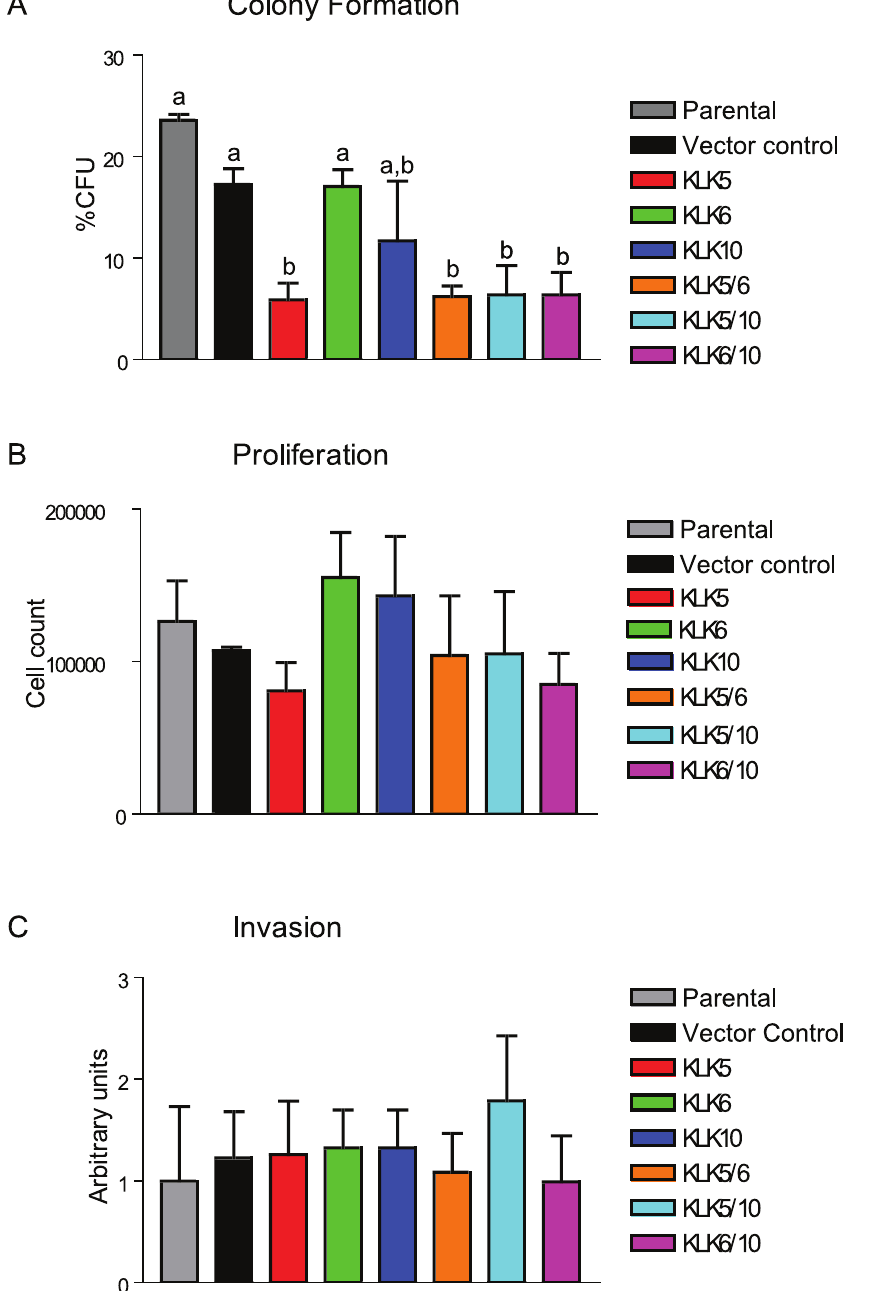
Figure 1. Clones overexpressing KLK5, 6 and 10, alone or in pairs, display differential anchorage-independent growth but do not differ in proliferation or invasive capacity. Three or more clones of the ES-2 cell line overexpressing KLK5, 6 or 10 or pairs of KLK5/6, KLK5/10 and KLK6/10 were compared to parental ES-2 cells or vector-transfected controls in vitro for their tumourigenic potential. A) Clones were grown in soft agar and the number of colonies was counted and is represented as percentage of the cells which formed colonies. B) Clones were grown for 96 h in serum-containing media and cell numbers were counted. C) Clonal cells resuspended in serum-free media were deposited in an insert coated with basement membrane extract and allowed to invade the transwell bathing in media with 10% serum for 24 h and migrating cells were quantified. The results are shown as the mean of 3 or more clones + / 2 SEM, and significance is inferred by one-way ANOVA with post test if p , 0.05. Different lower-case letters above each bar indicate statistically significant differences between values (p , 0.05). In C, the data are normalized to the parental control.